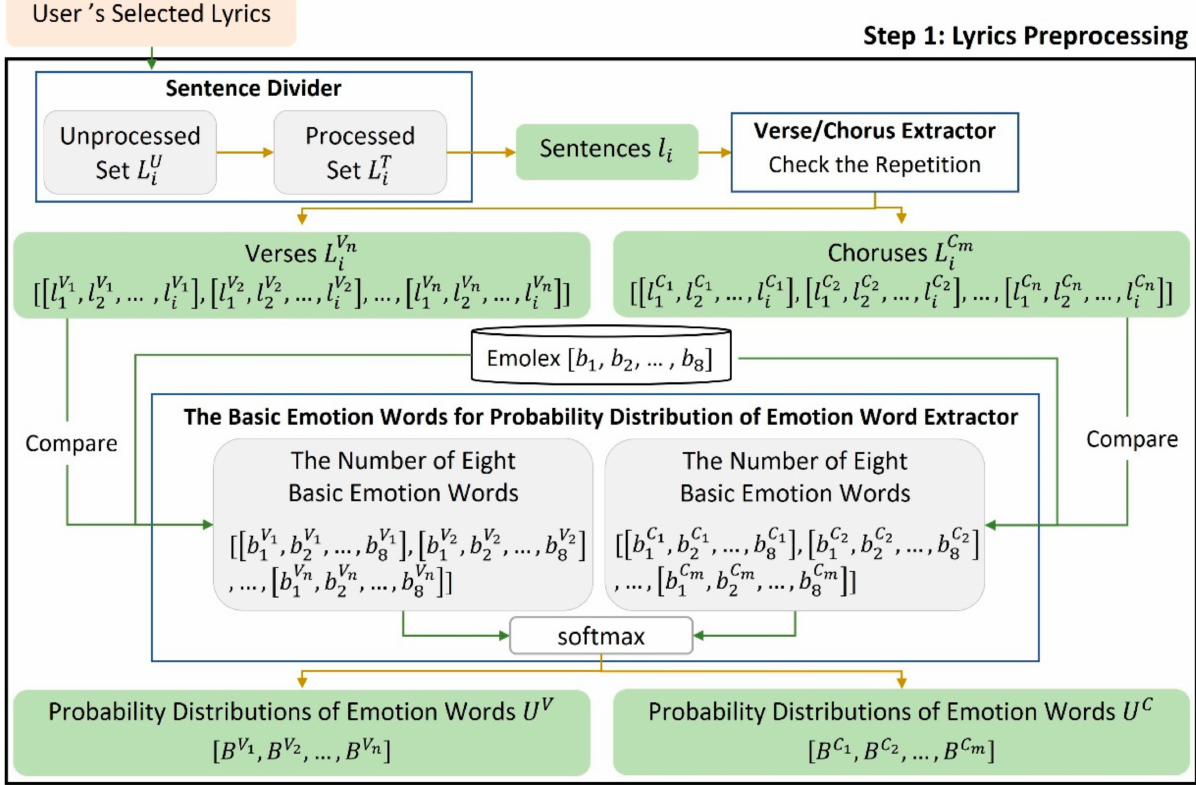
Figure 2. Step 1: Lyric